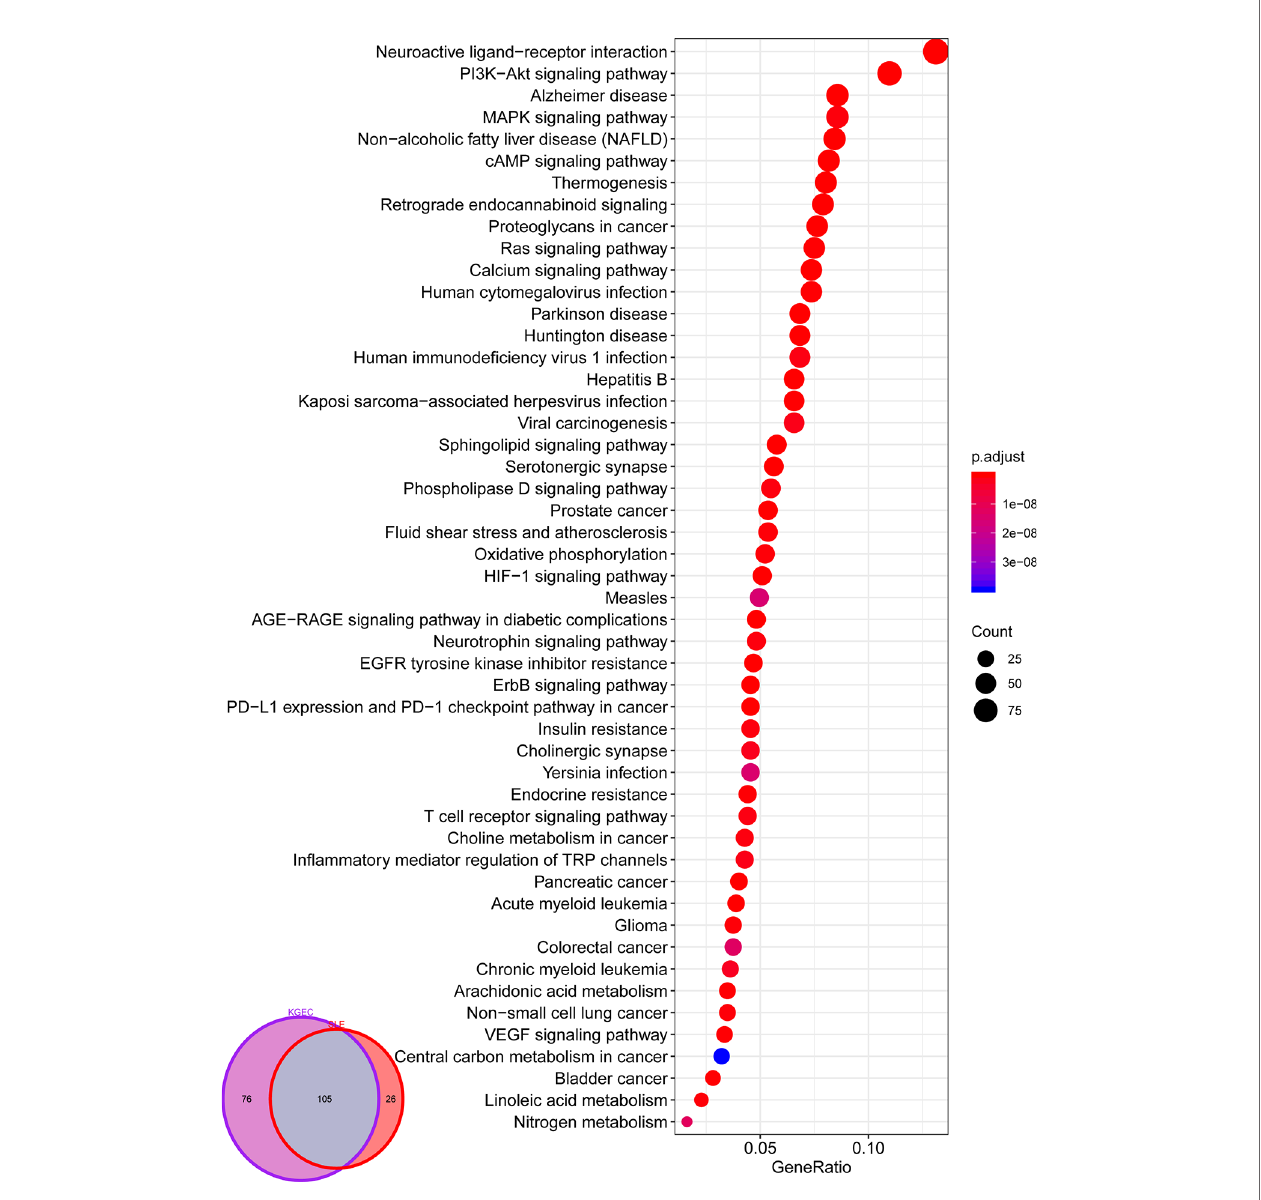
FIGURE 8 | Pathway enrichment analysis of KGEC Targets. Veen diagram for pathway enrichment analysis of KGEC targets and SLE related genes; The size of the circle represents the number of genes enriched in the pathways, and the color change of the circle represents the signi fi cant degree of the enriched genes in the